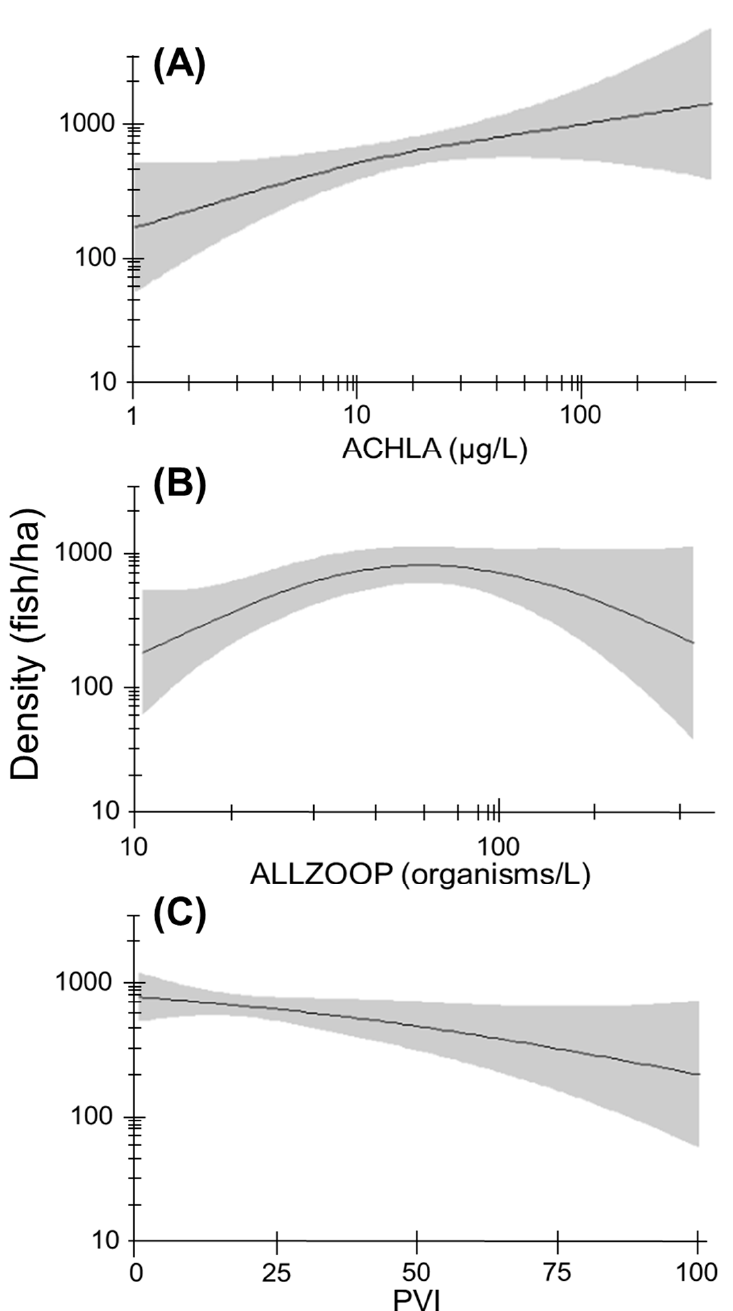
Figure 2. Generalized additive model relating Bluegill density (fish/ha) to ( A ) adjusted chlorophyll- a concentration (ACHLA, μ g/L, p = 0.005), ( B ) total zooplankton density (ALLZOOP, organisms/L, p = 0.030), and ( C ) percent of lake volume inhabited with macrophytes (PVI, p = 0.050) in Florida lakes. Shaded areas are 95% confidence intervals.